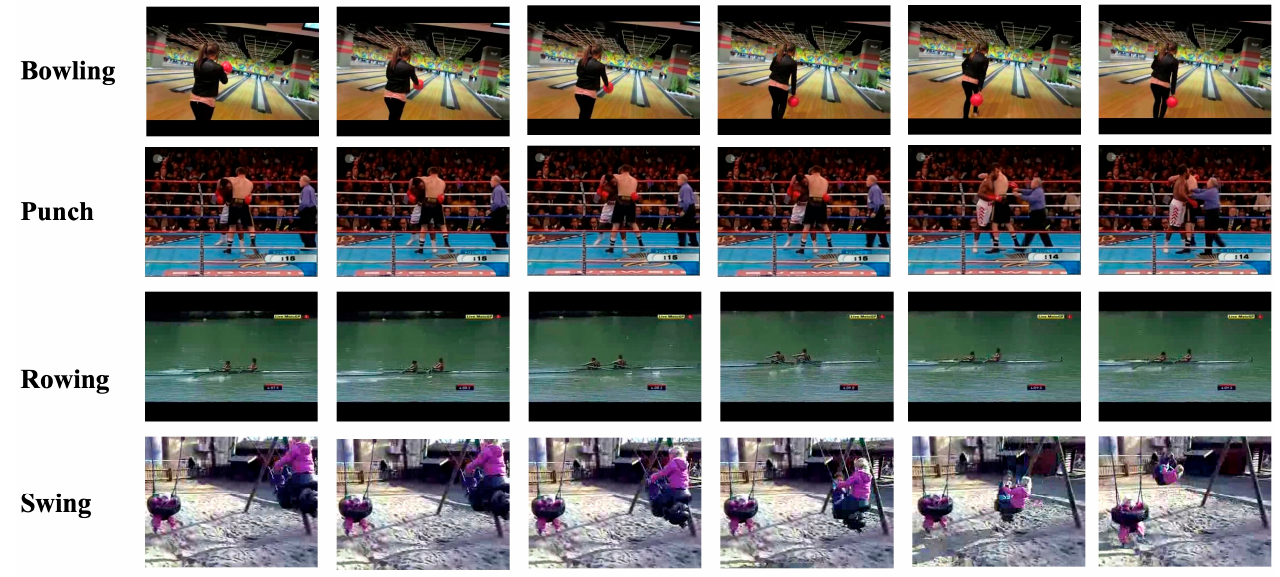
Figure 7. Frame examples of the UCF101 dataset.